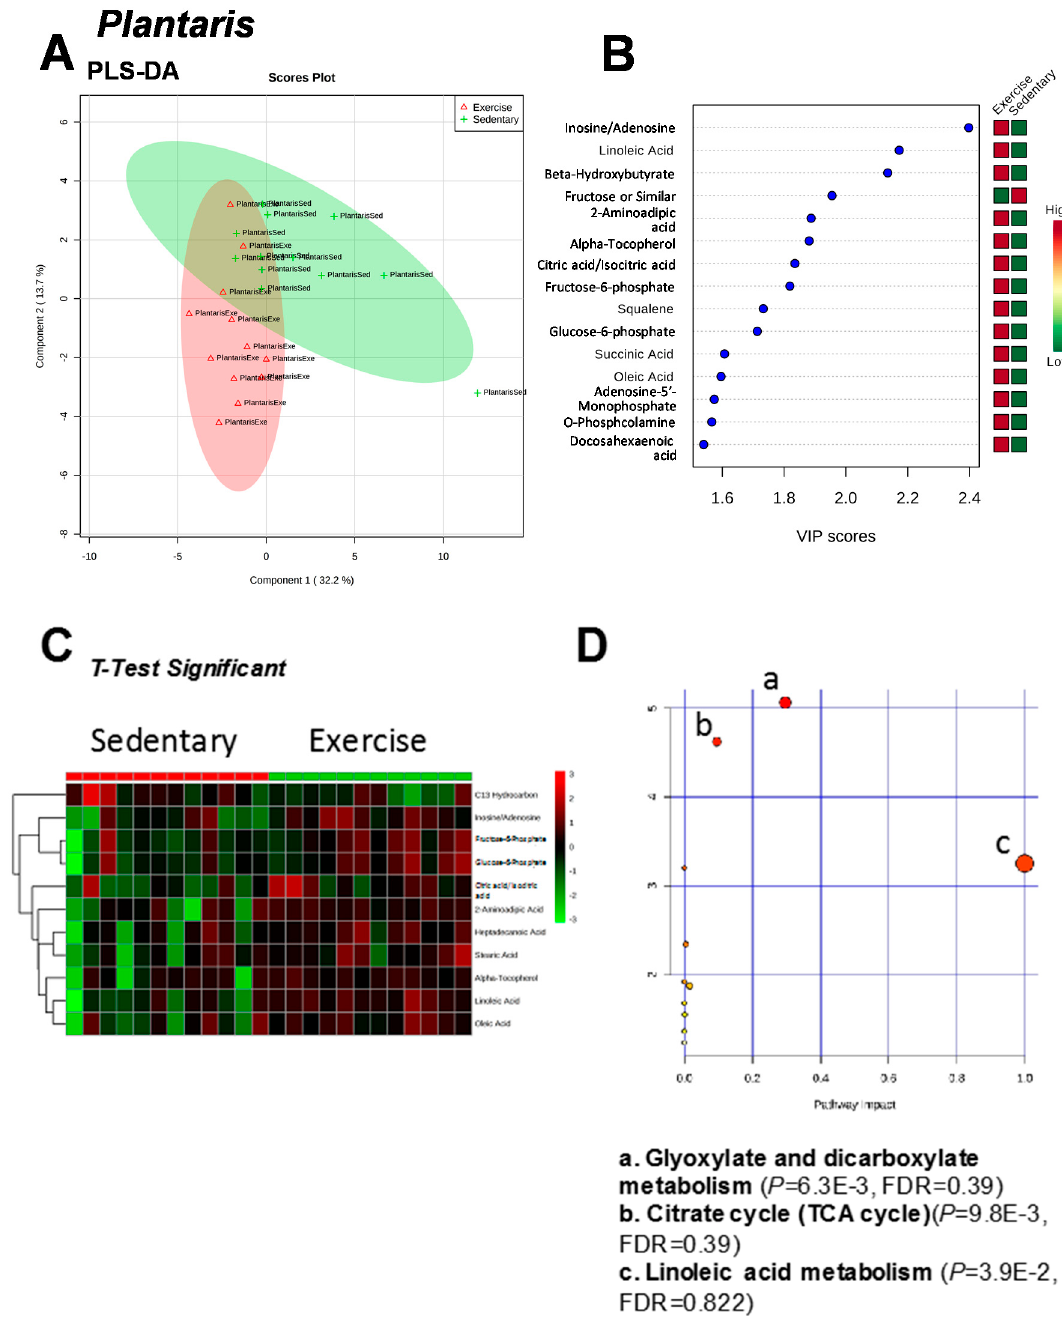
Figure 2. Analysis of non-targeted metabolomics of plantaris muscle from exercise-trained and sedentary control rats. ( A ) Partial Least Squares Discriminant Analysis (PLS-DA). ( B ) PLS-DA Variable Importance in the Projection (VIP) significant metabolites. ( C ) t -Test significant metabolites ( P < 0.05). ( D ) Pathway analysis based on t-test significant metabolites. N = 12/group.